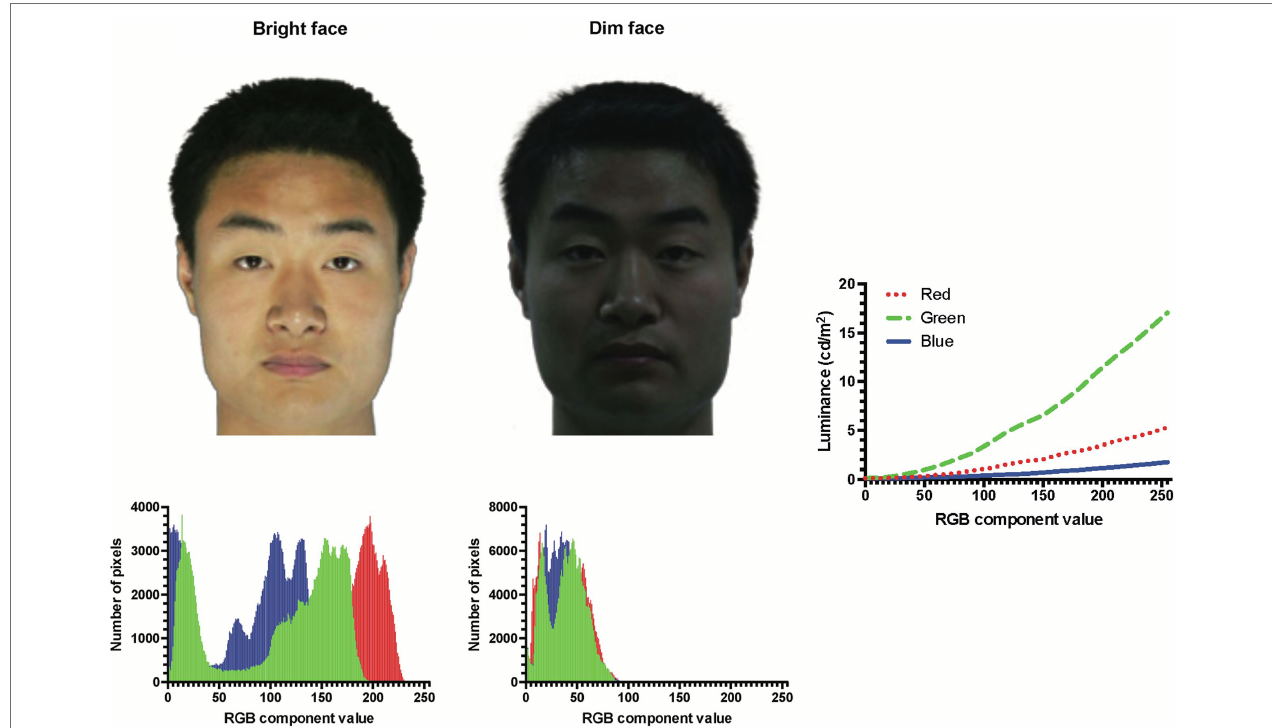
FIGURE 1 | Example faces (top row) of the same identity under bright (left) or dim (right) lighting and their corresponding color histograms (bottom row). In actual experiments, the faces were displayed against a black background in a dark room. The rightmost plot shows the screen luminance as a function of RGB component value measured by a